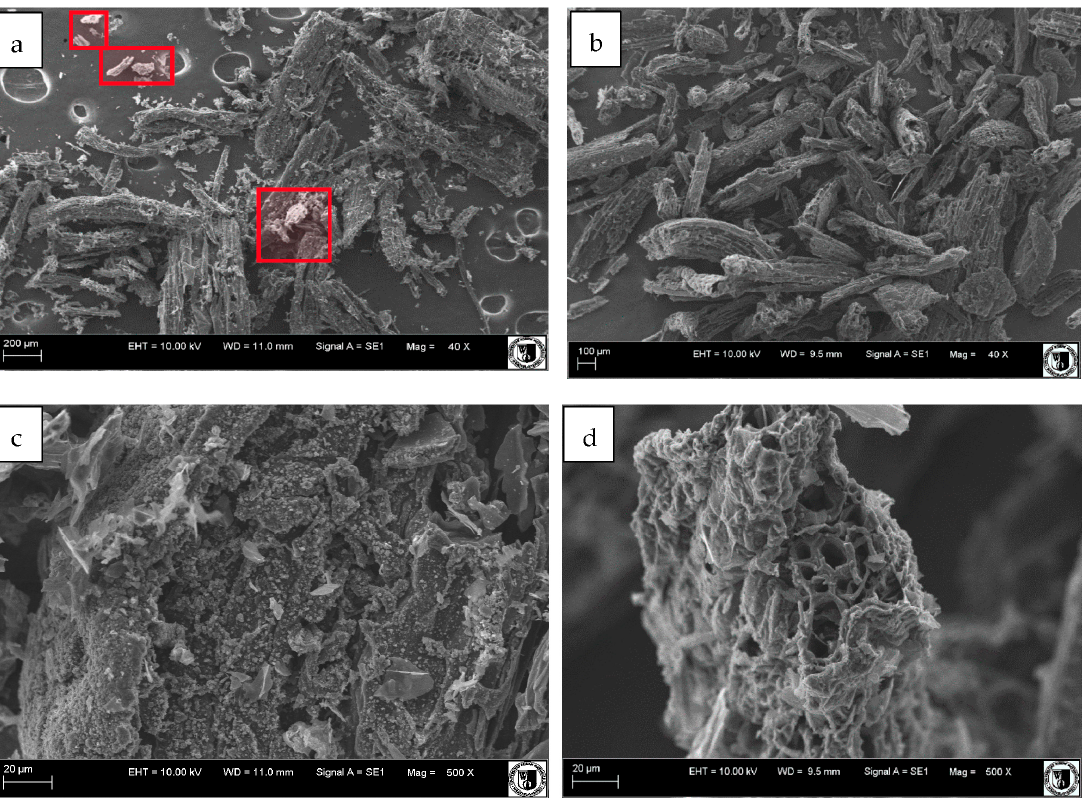
Figure 2. Scanning electron microscopy images amplified 40 times ( a , b ) and 500 times ( c , d ) of the pristine ( a , c ) and deashed biochar ( b , d ). Ash particles are highlighted in red.